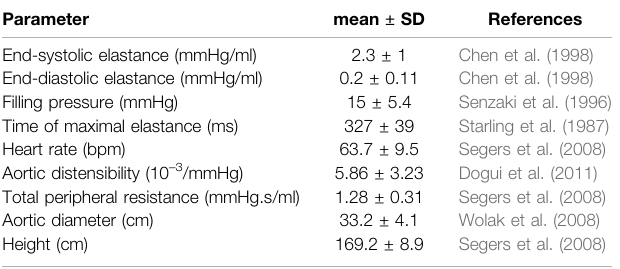
TABLE 2 | Selected distributions of the model ’ s input parameters based on the literature. Parameter mean ±